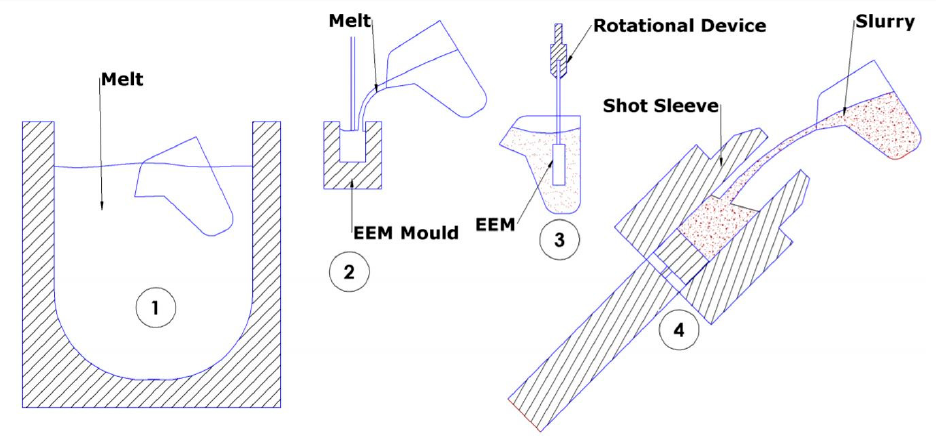
Figure 2. The RheoMetal process (courtesy Comptech).